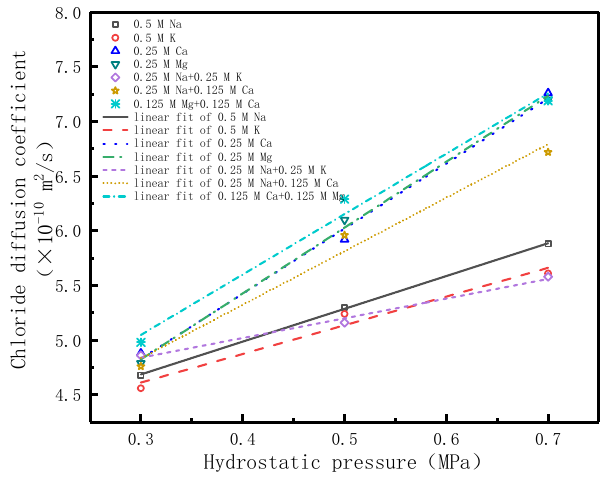
Figure 8. The relationship between chloride diffusion coefficient and hydrostatic pressure. Table 7. Fitting equations of the chloride diffusion coefficient and hydrostatic pressure. Cationic Type Fitting Equation Correlation Coefficient (R 2